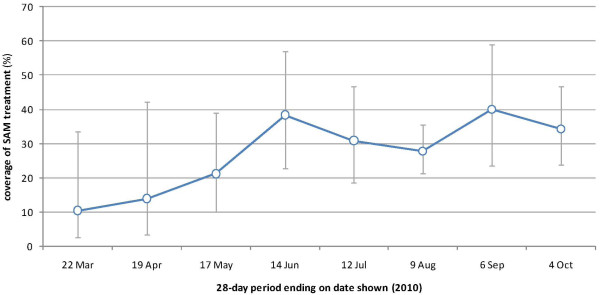
Coverage of SAM by month, 2010.